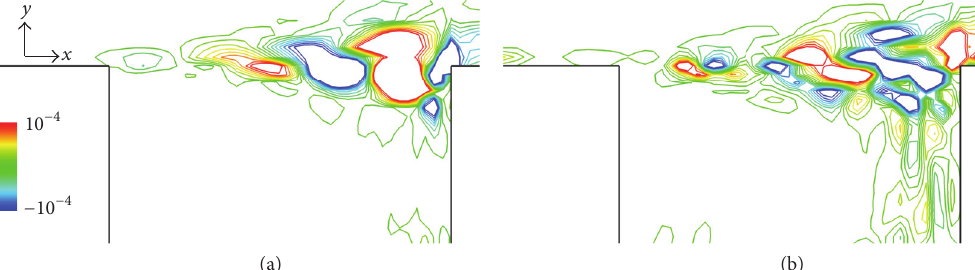
Figure 20: Contours of real part of power of Lighthill’s stress tensor at fundamental frequency, 𝜕 2 T for cavity flows without acoustic resonance ( D / L = 0.5). (a) Cavity flow without freestream turbulence (Tu = 0.0%). (b) Cavity flow with freestream turbulence, Tu = 2.3%.